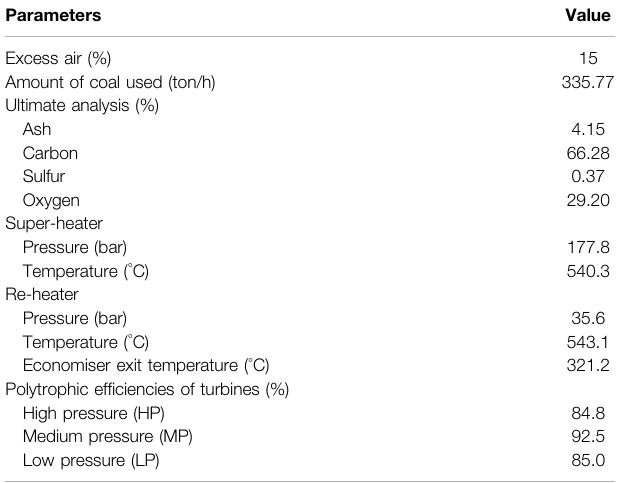
TABLE 1 | General information on the referenced